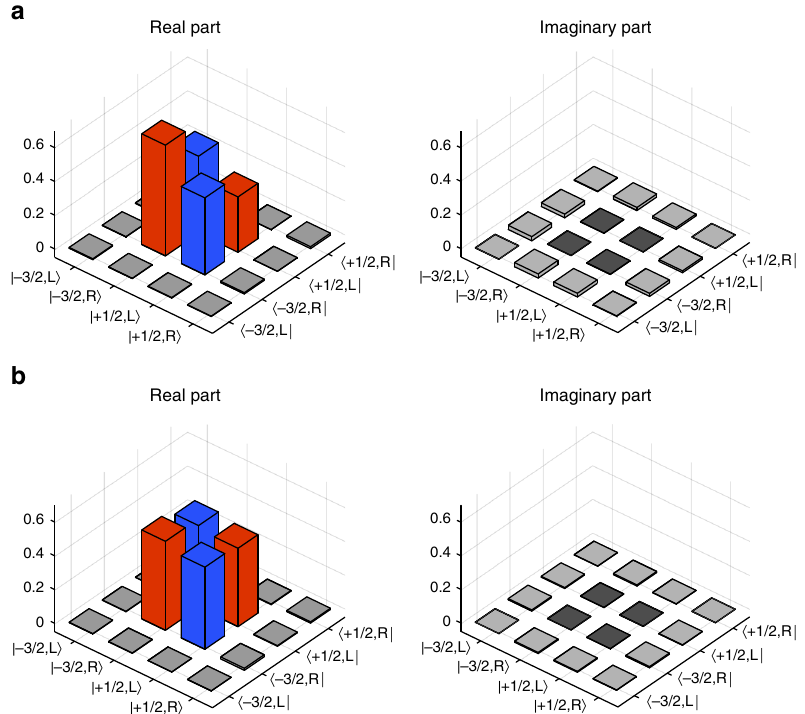
Fig. 4 Quantum-state tomography of the ion – telecom-photon entangled states. Real and imaginary parts of the density matrices for: a the converted “ bare ” ion – photon entangled state still revealing the asymmetry in the diagonal elements (red bars) due to the asymmetric Clebsch – Gordan coef fi cients, b the converted ion – photon entangled state projected onto a Bell state by introducing polarization-dependent